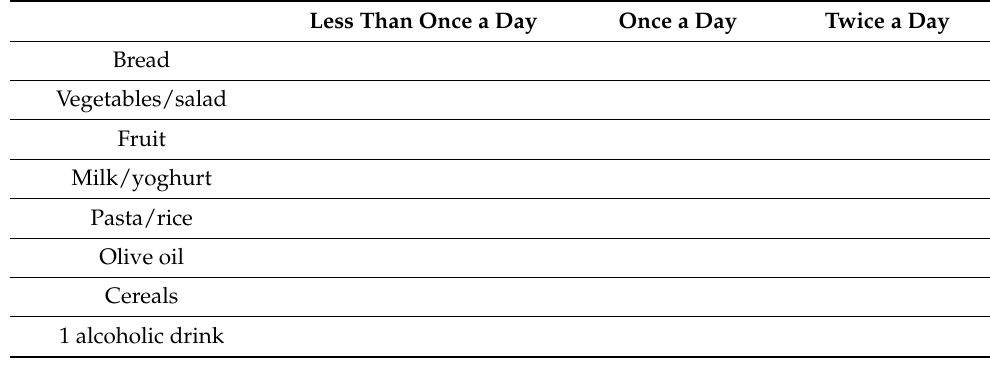
Table A1. Eating habits (a).